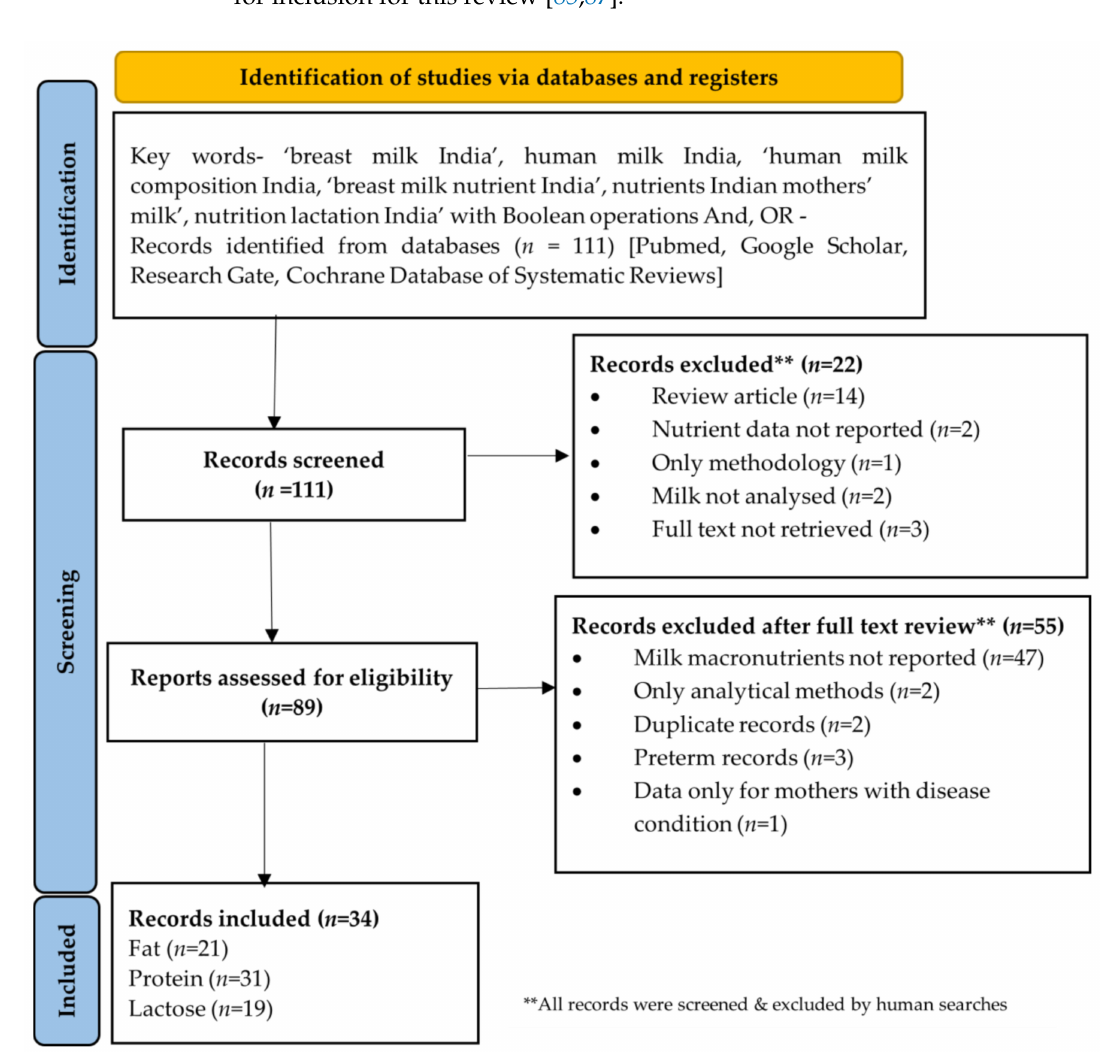
Figure 1. PRISMA flow chart for systematic review study